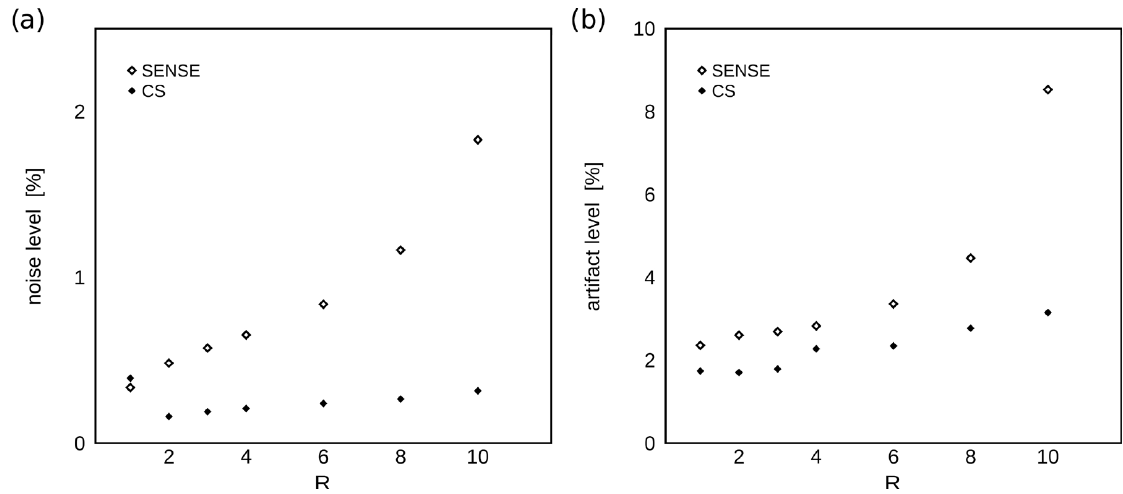
Figure 5. Water peak height image quality measures as a function of R. ( a ) The dependence of the noise level (relative to agar signal) on the acceleration factor R is shown for SENSE and CS acceleration schemes. ( b ) The dependence of the geometric artifact level (relative to agar signal) on R is shown for SENSE and CS acceleration schemes. The noise and artifact levels are relatively constant or increase minimally with R for CS but increase approximately 5.5-fold and 4-fold, respectively, for SENSE-accelerated imaging at R = 10.